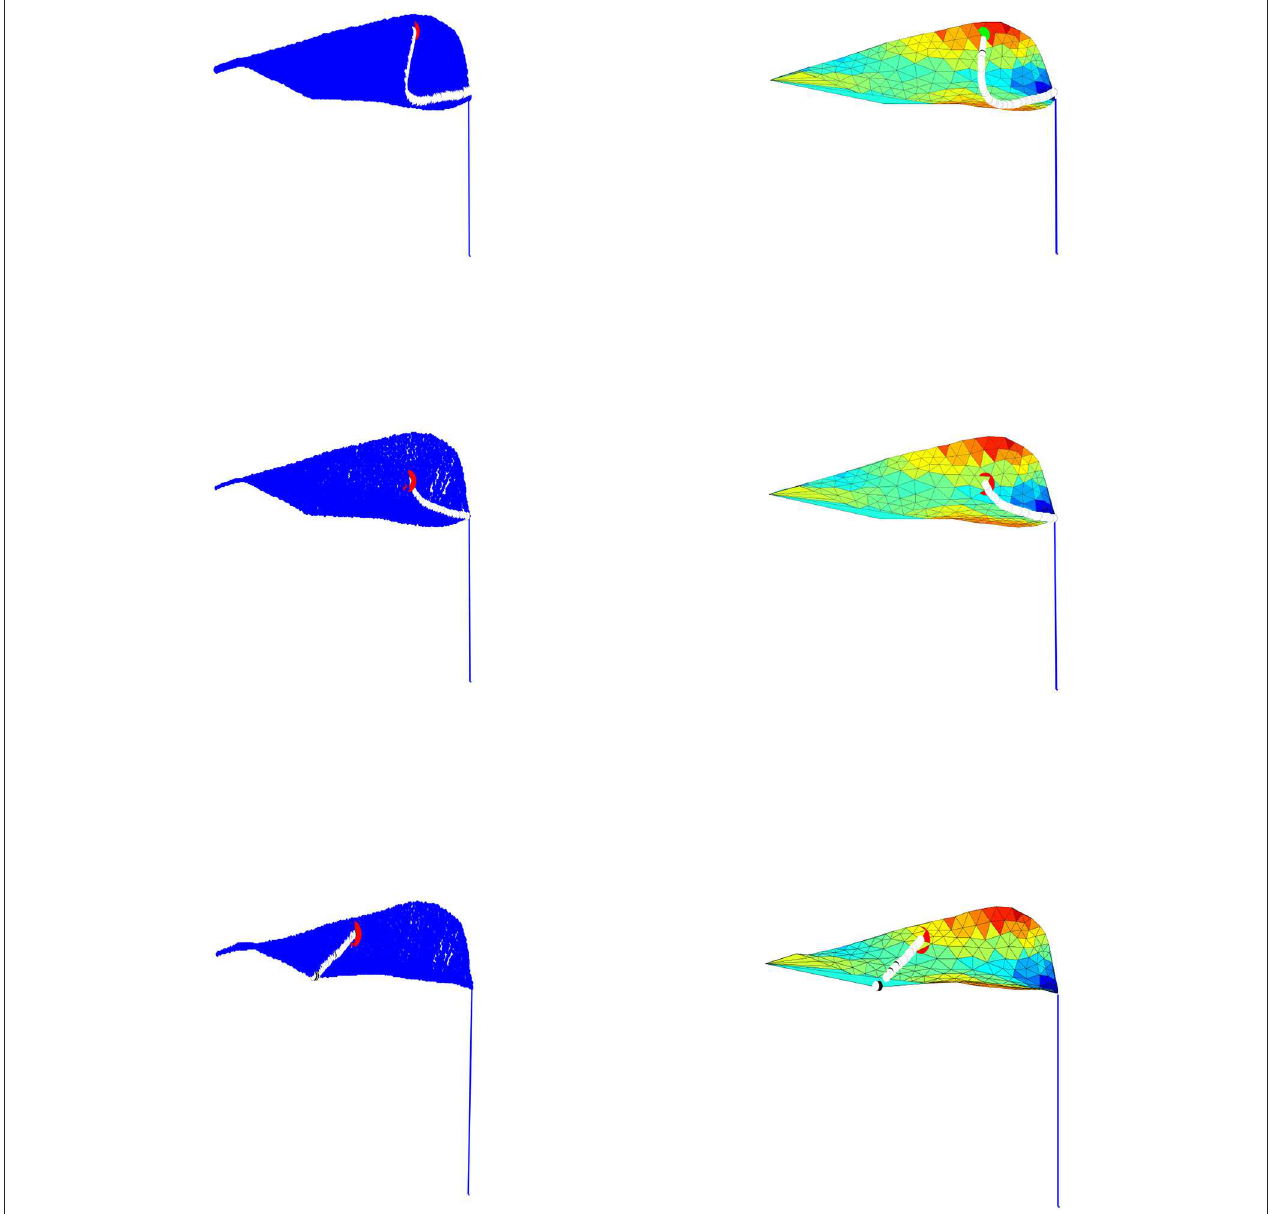
FIGURE 5 | The figures given on the left column represent the droplet motion employed by our model across the constructed leaf, while the figures given on the right column show the corresponding droplet movement on the leaf triangulation.